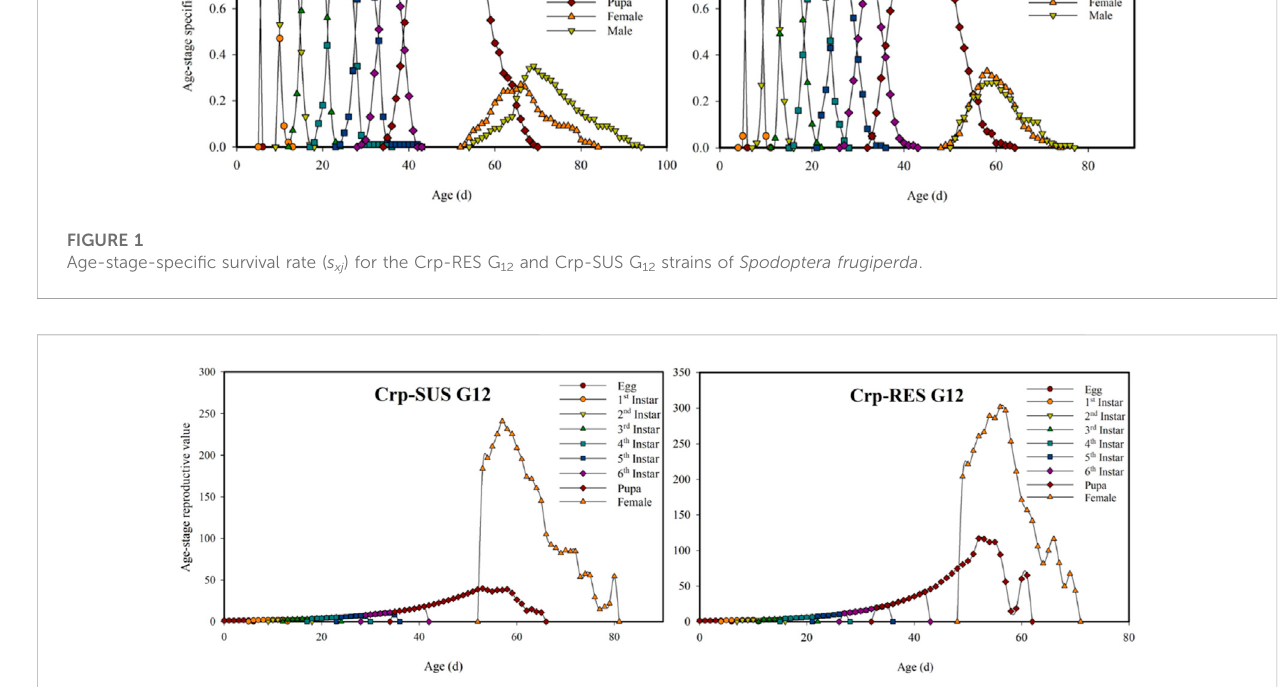
FIGURE 2 Age-stage reproductive value ( v xj ) for the Crp-RES G 12 and Crp-SUS G 12 strains of S. frugiperda .